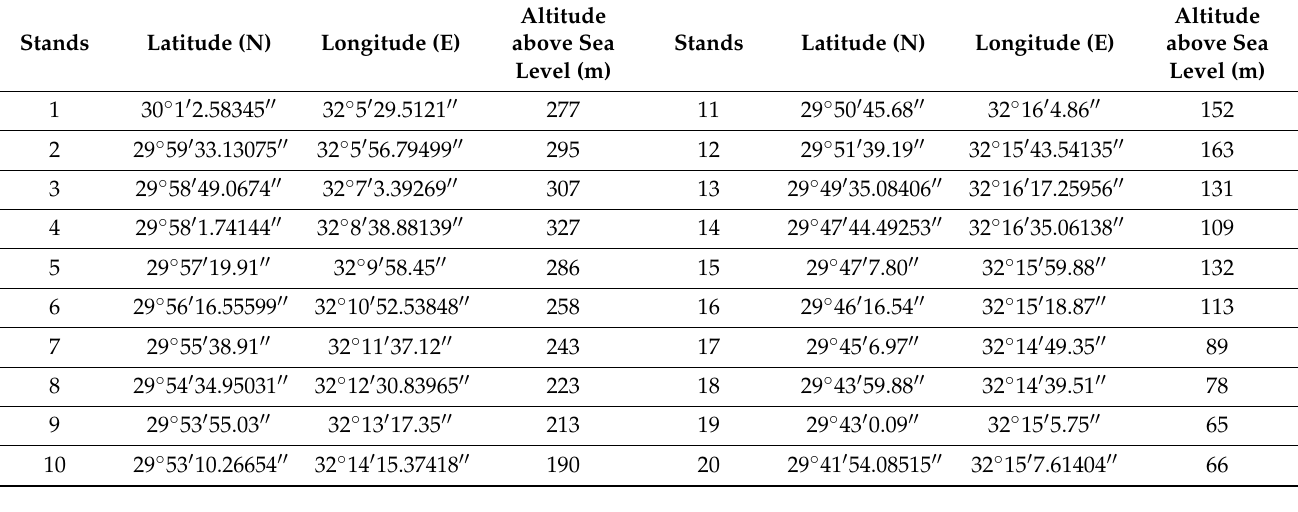
Table 1. Global Positioning System coordinates of the studied localities in Wadi Hagul.